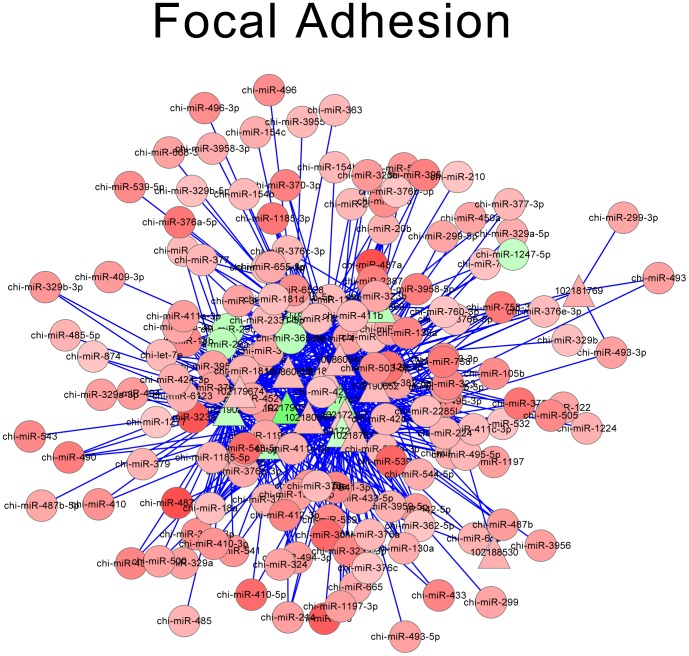
Network of focal adhesion.Red triangle: up-regulated DE-targets; Green triangle: down-regulated DE-targets; Red roundness: up-regulated miRNAs; Green roundness: down-regulated miRNAs. The deeper the color, the stronger the trend.